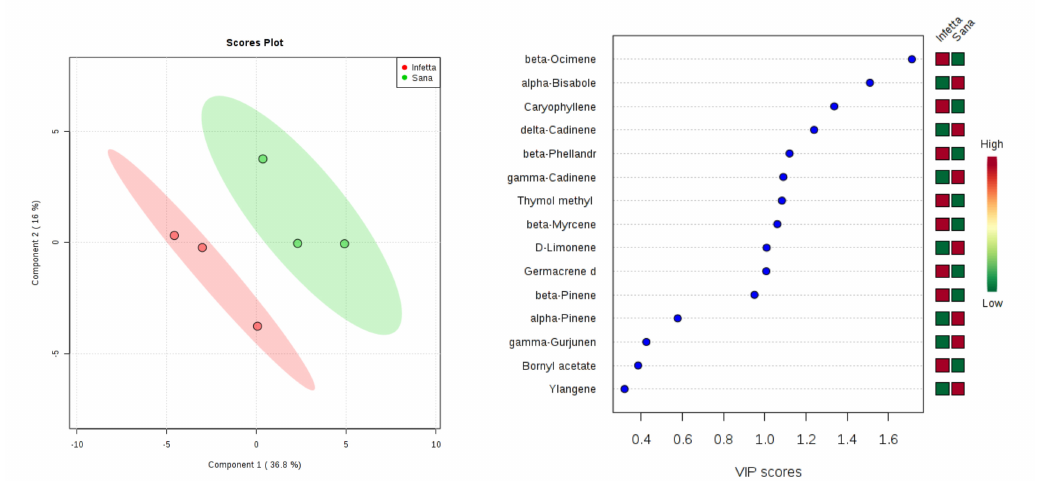
Figure 7. Partial least squares discriminant analysis applied to the Sampling #4 (PROCE-1) in Bova. Parameters and symbols as in Figure